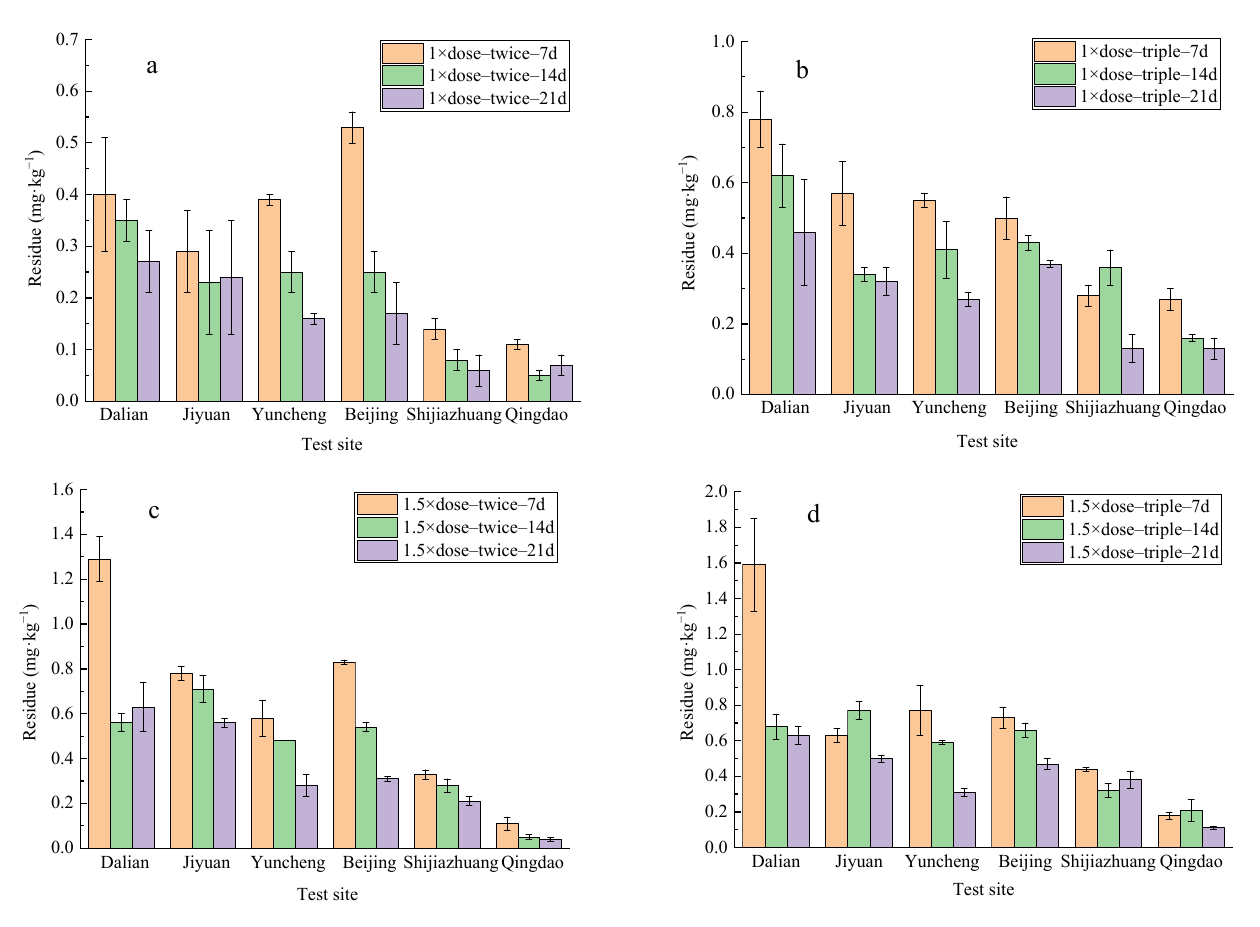
Figure 4. Difenoconazole final residues on jujube in six field trials under different treatments (( a ). 1 × dose twice, ( b ). 1 × dose triple, ( c ). 1.5 × dose twice, ( d ). 1.5 × dose triple).